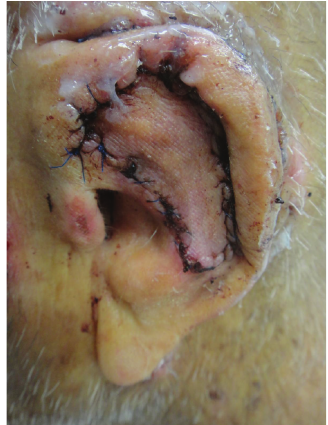
Figure 6: The flap was inset into the defect and sutured into place.